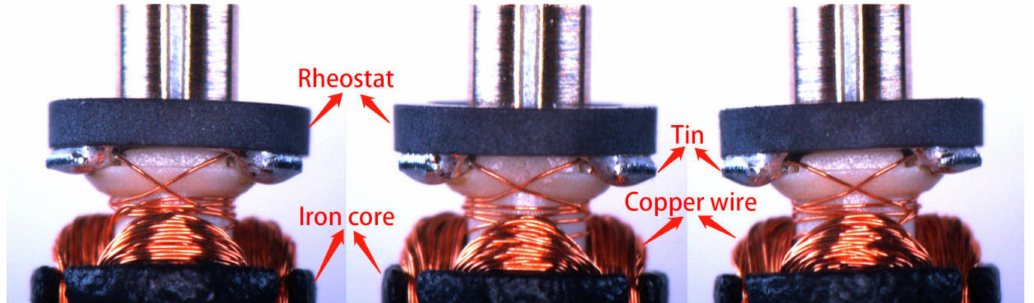
Figure 3. The picture of an armature we obtained from three